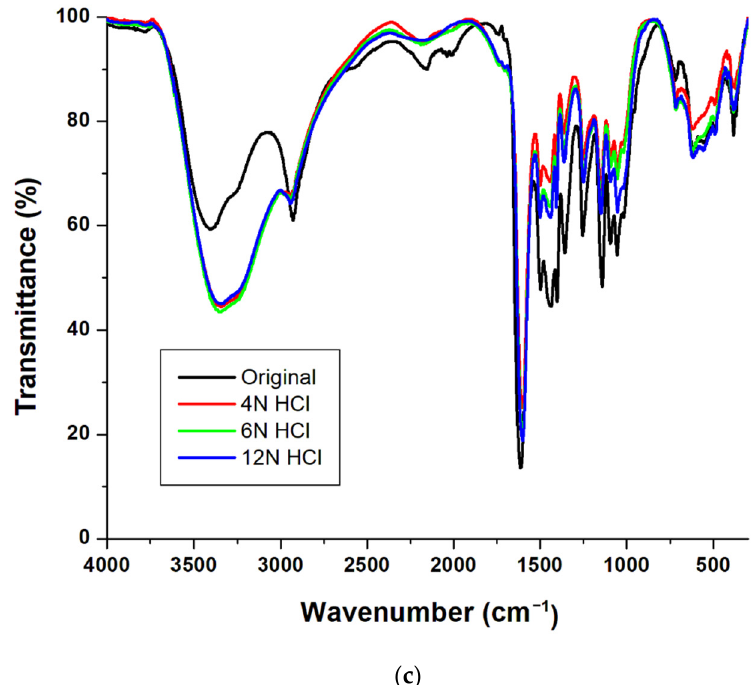
Figure 4. IR spectra of amino-Li-resin after overnight treatment in ( a ) 100% DBU, BF 3 -OEt 2 and untreated resin, ( b ) 100% TFA, 50% NaOH in H 2 O, 20% piperidine in DMF and untreated resin, and ( c ) 4N, 6N, and 12N HCl and untreated resin. Table 1. Swelling of the selected resins in green and non-green